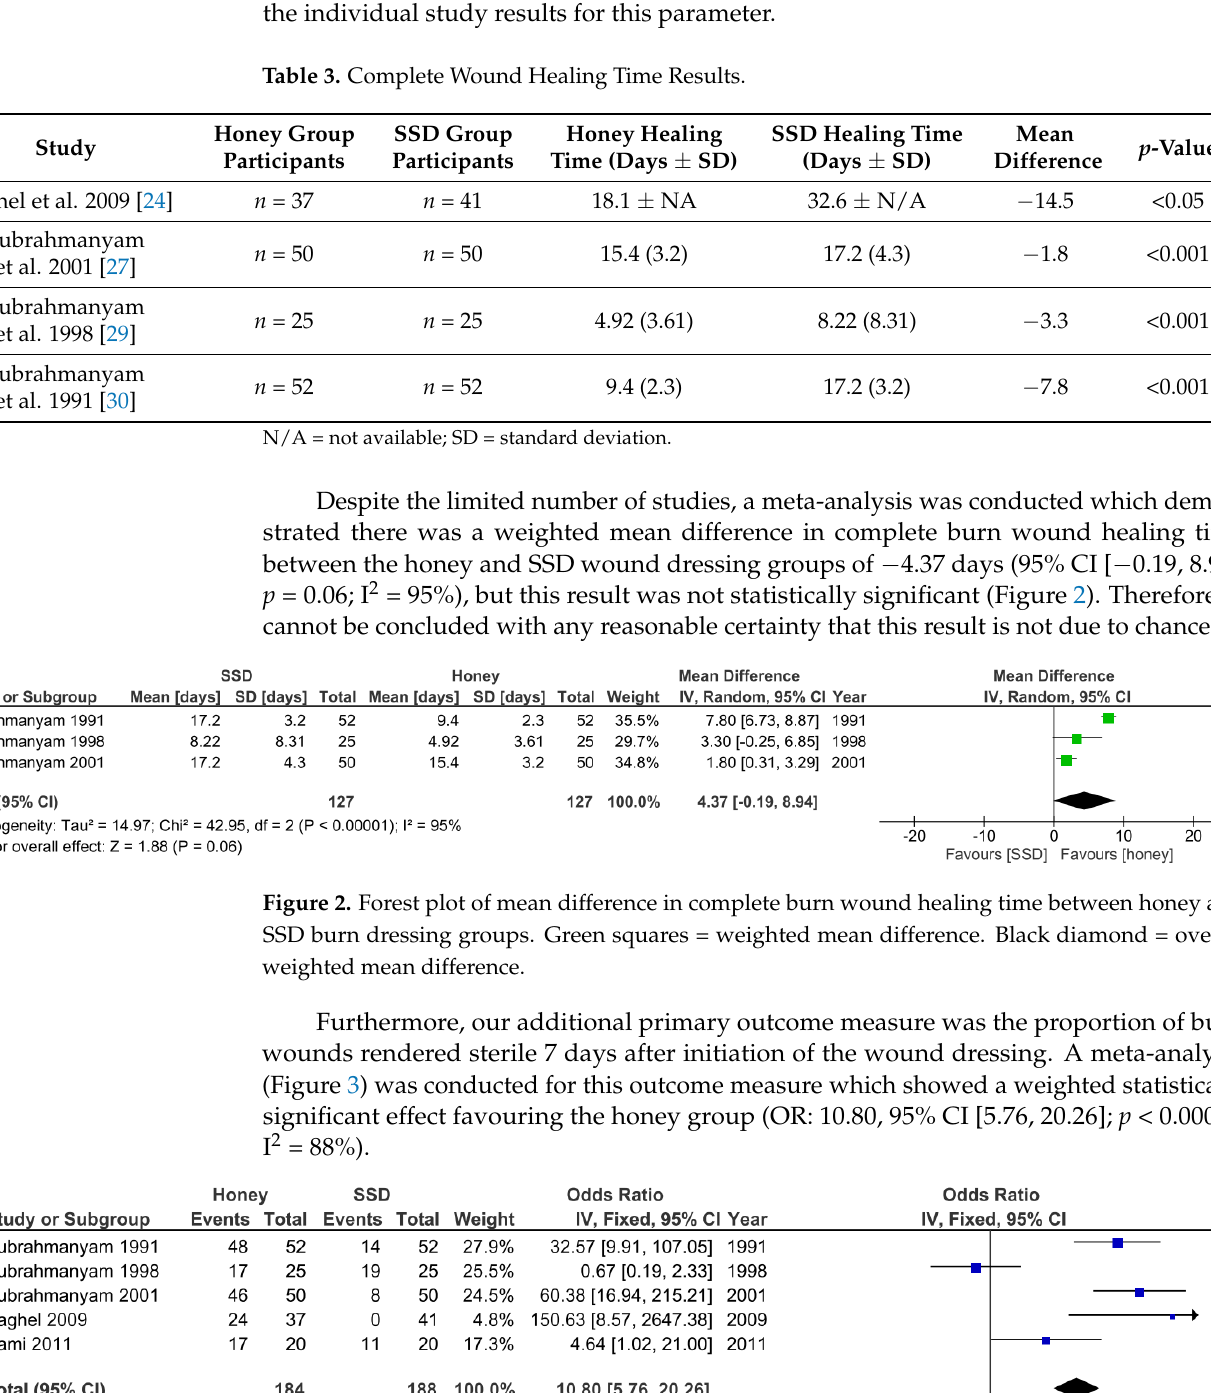
Table 3. Complete Wound Healing Time Results.